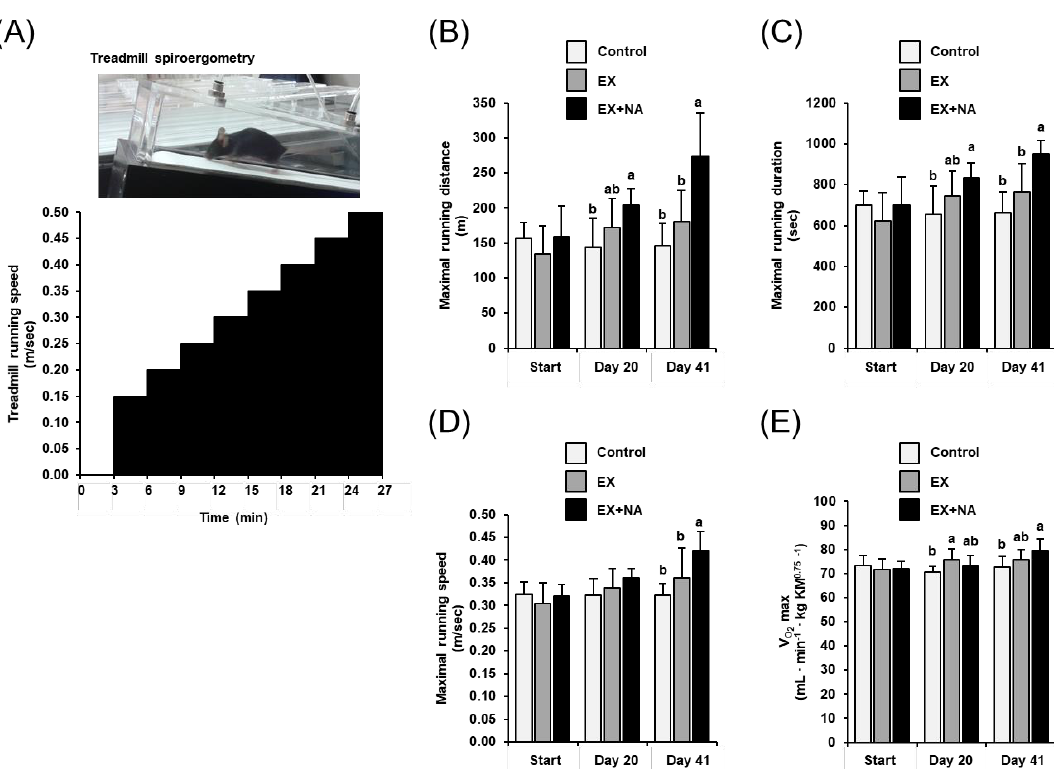
Figure 2. Development of endurance exercise performance in sedentary mice fed an NA (nicotinic acid) adequate diet (Control) and mice subjected to regular endurance exercise fed either an NA adequate diet (EX) or a high NA diet (EX + NA) for 6 weeks. Endurance exercise performance was determined by means of a maximal running test on a treadmill spiroergometry ( A ). Following a short equilibration phase of 3 min in the airtight treadmill at 0 m / sec, the maximal running test started at a running speed of 0.15 m / sec for 3 min followed by a step-wise increase of running speed by 0.05 m / sec every 3 min until exhaustion. As parameters of endurance exercise performance maximal running distance ( B ), maximal running duration ( C ), maximal running speed ( D ) and maximal oxygen uptake (VO 2 max) ( E ) were determined. Bars represent means ± SD for n = 10 animals per group. Bars without a common lowercase letter (a, b) differ, P < 0.05.